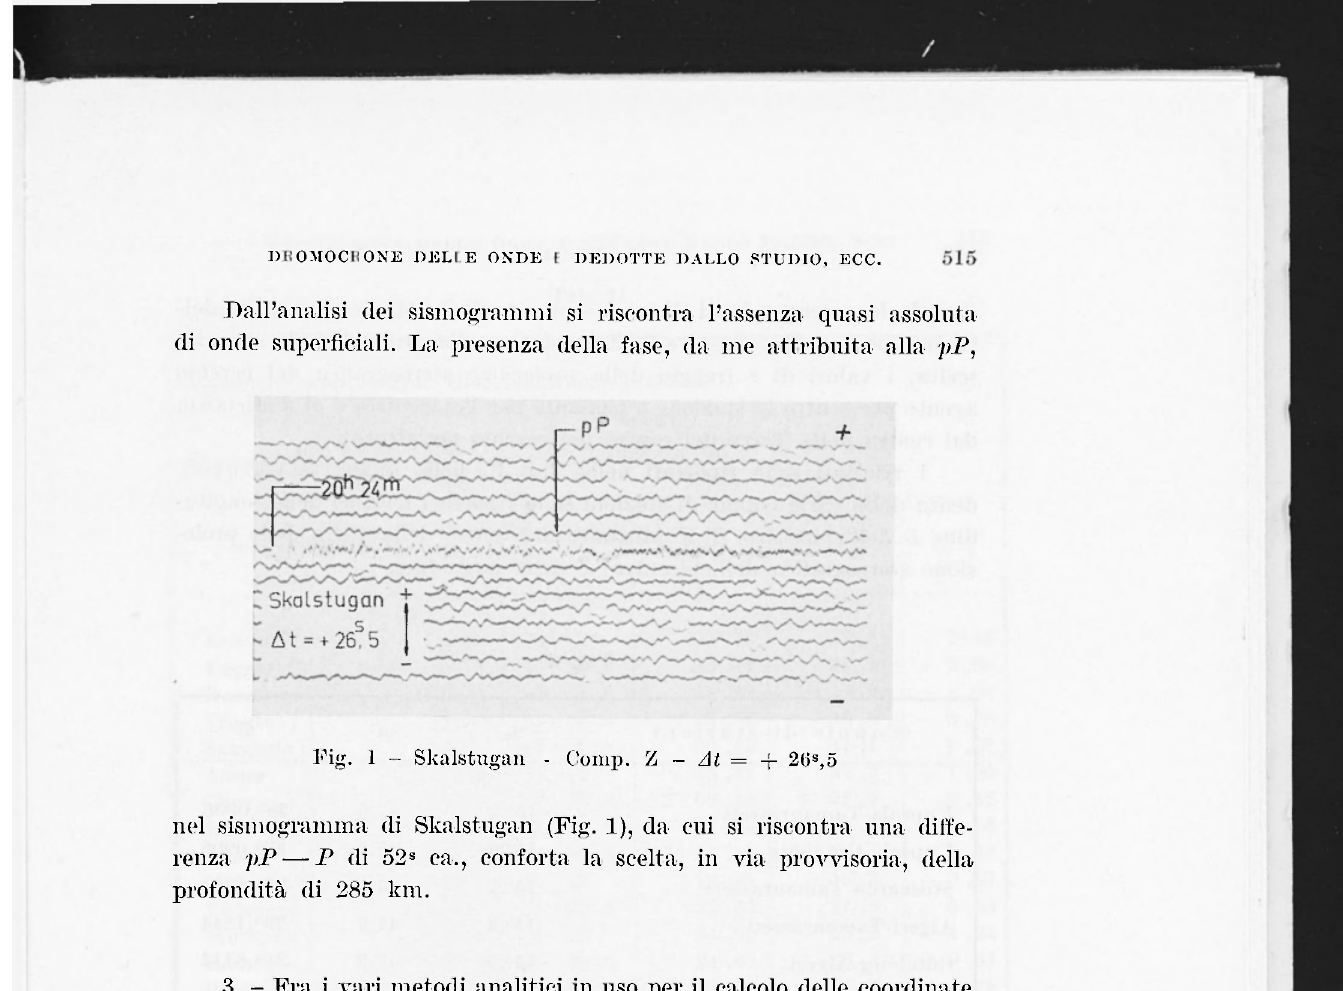
Fig. 1 - Skalstugan - Comp. Z - At = + 26 s